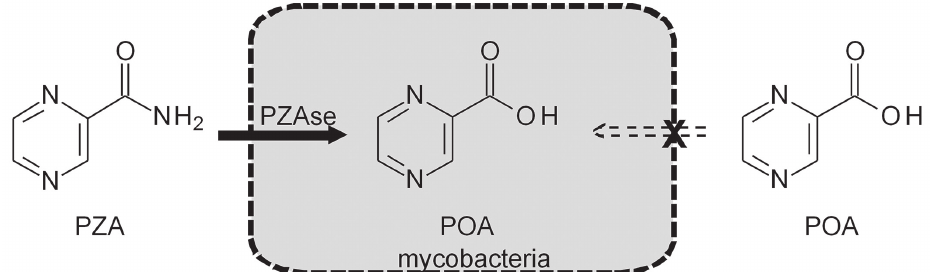
FIGURE 1 – Illustration of the mechanism of action of the pyrazinoic acid (POA) prodrugs, which POA itself cannot penetrate the mycobacterial membranes, whereas pyrazinamide (PZA) is activated to pyrazinoic acid (POA) inside